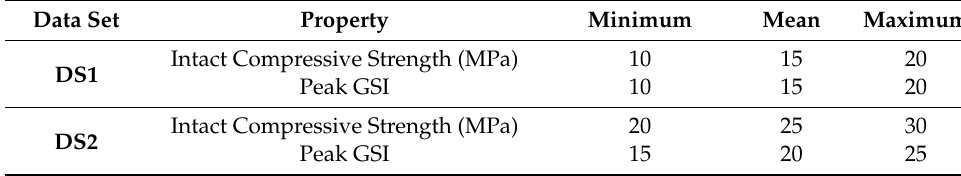
Table 2. Peak GSI and UCS minimum, mean, and maximum values.